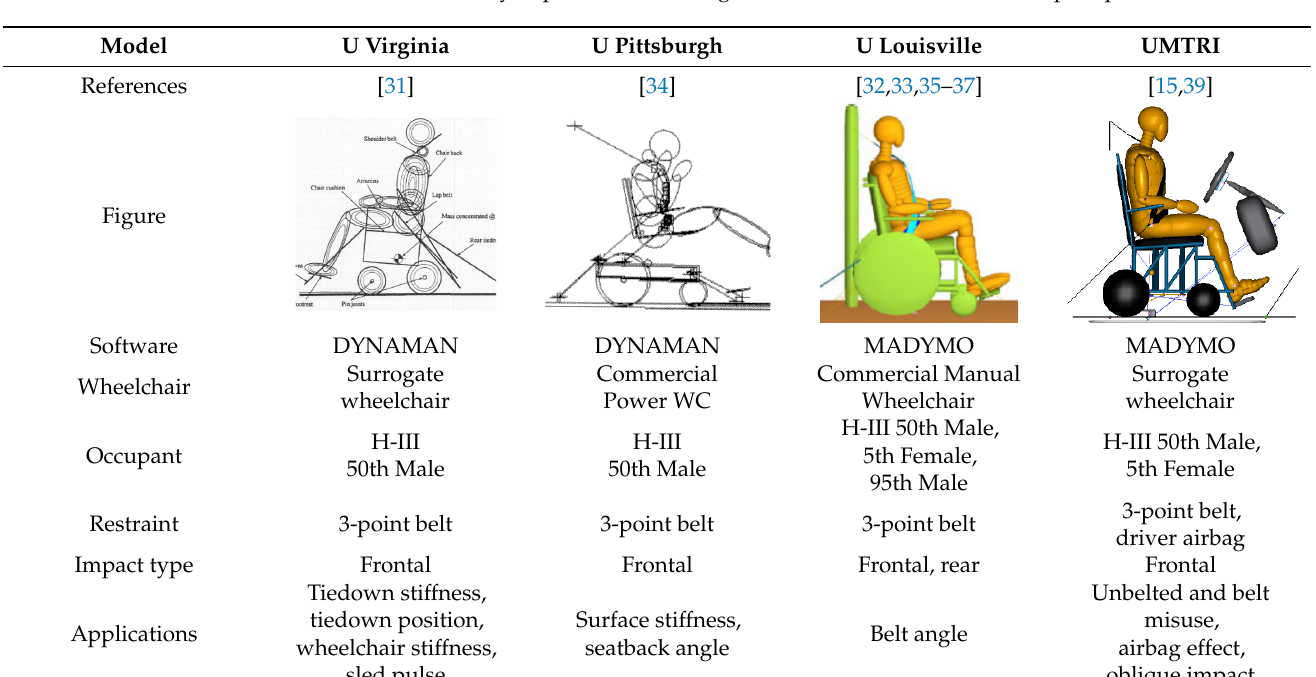
Table 2. Summary of previous modeling work related to wheelchair occupant protection.